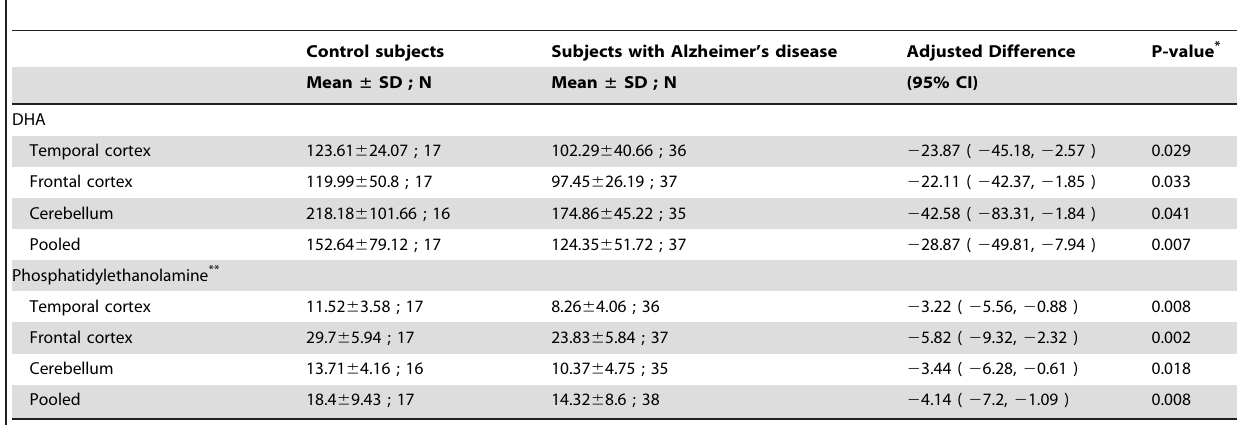
Abbreviations: CI, confidence interval. *P-values for differences between means were computed by linear regression analysis for each fatty acid in selected brain regions and Generalized Estimating Equations for the pooled analysis in the entire brain after adjustment for age, gender, and post mortem interval.